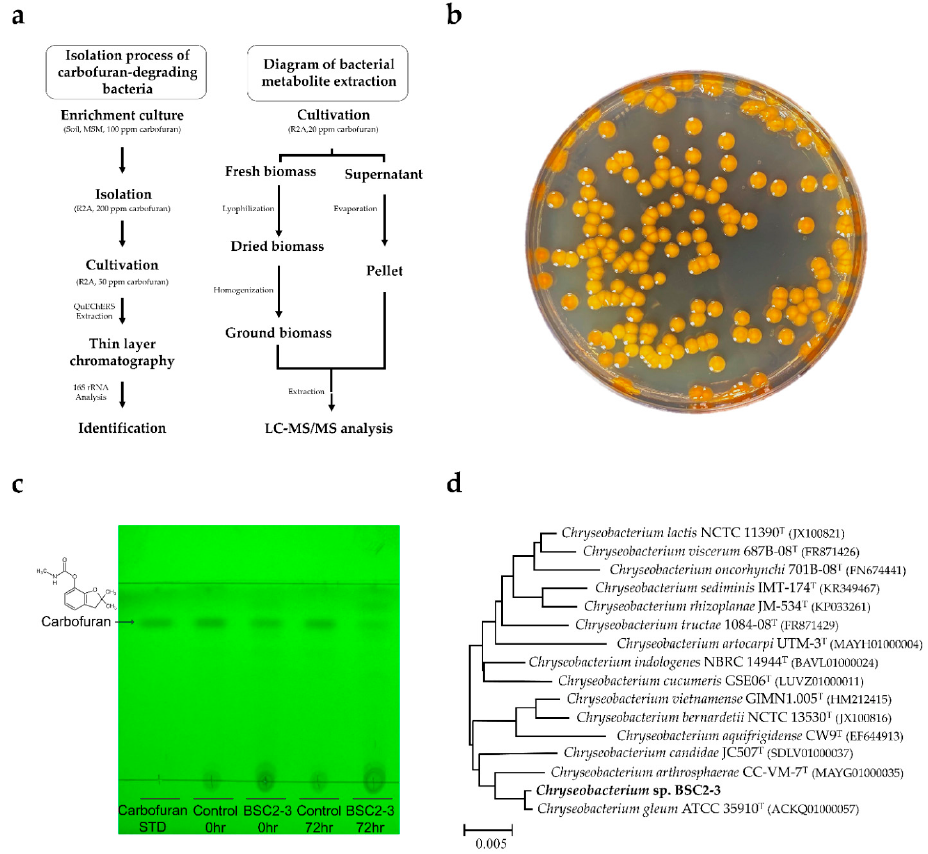
Figure 1. Experimental procedure, cell morphology, thin ‐ layer chromatography results and phylogenetic tree analysis of BSC2 ‐ 3 cells. ( a ) A schematic diagram of the experimental process. ( b ) BSC2 ‐ 3 on R2A solid medium containing 200 ppm carbofuran. ( c ) TLC analyses of metabolites of Chryseobacterium sp. BSC2 ‐ 3 cultured in R2A medium with 50 ppm carbofuran. Carbofuran STD, 2000 ppm carbofuran; Control 72 h, 72 h culture extract of R2A with 50 ppm carbofuran; BSC2 ‐ 3 0 h, 0 h culture extract of the BSC2 ‐ 3 with 50 ppm carbofuran; BSC2 ‐ 3 72 h, 72 h culture extract of the BSC2 ‐ 3 strain with 50 ppm carbofuran. ( d ) Phylogenetic tree of BSC2 ‐ 3 based on 16S rRNA analysis. The sequences were aligned using ClustalW, which was operated by the MEGA X alignment platform with 1000 bootstrap replicates. The phylogenetic tree was constructed by using the neighbour ‐ joining method. The scale bar represents the number of substitutions per site.